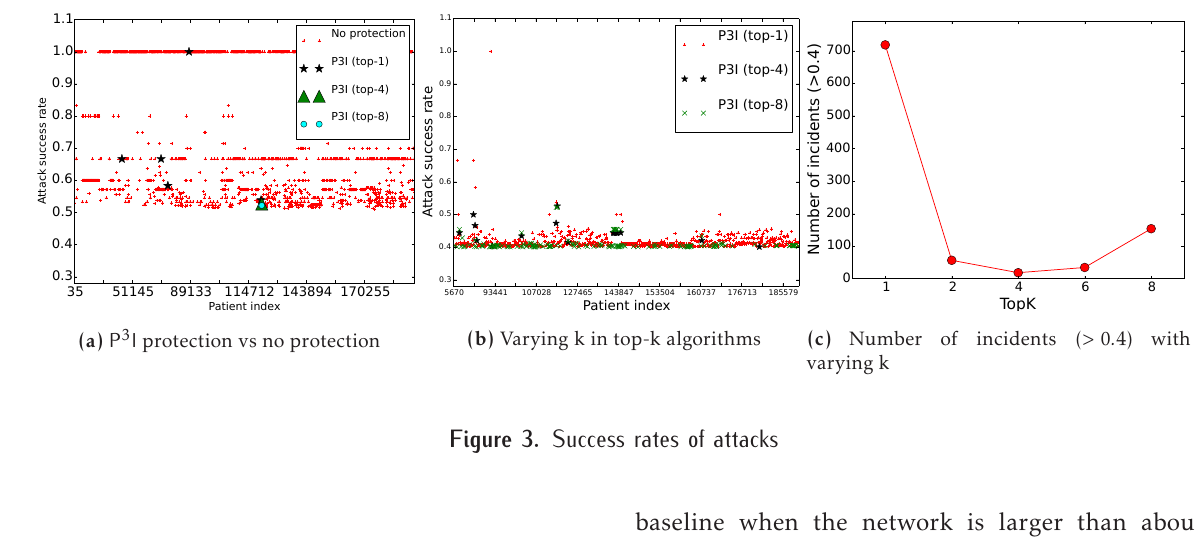
Figure 3. Success rates of attacks